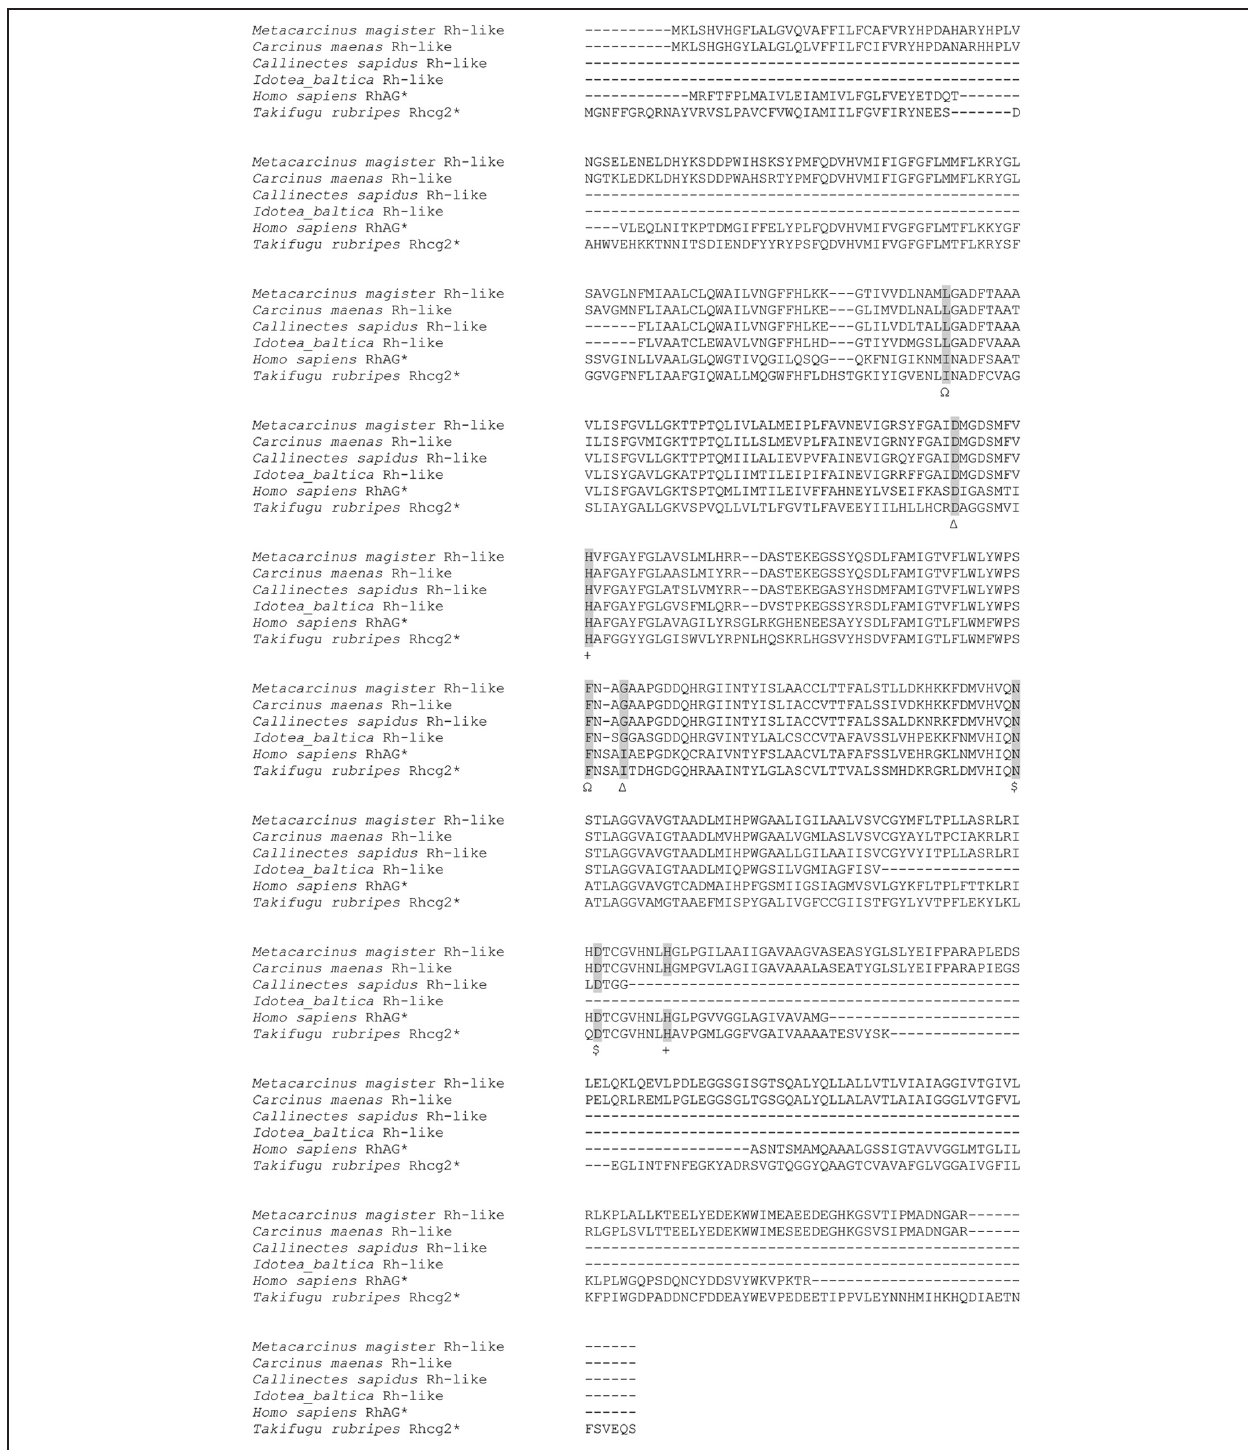
FIGURE 7 | Clustal W amino acid alignment (Thompson et al., 1994) of crustacean Rh- protein with two vertebrate Rh-proteins of verified ammonia transport capability. Conserved ammonia-conducting residues are highlighted with a shaded background. Symbol (cid:2) designates ammonia-conducting residues in the external vestibule; symbol (cid:3) designates ammonia-conducting residues in the pore entrance; symbol + designates ammonia-conducting residues in the pore center; symbol $ designates